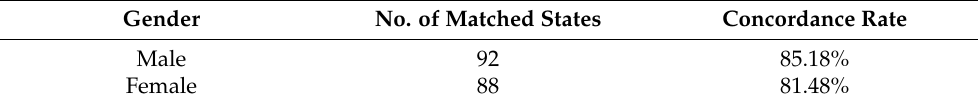
Table 6. Concordance rate between model’s recommendation and doctor’s prescriptions.